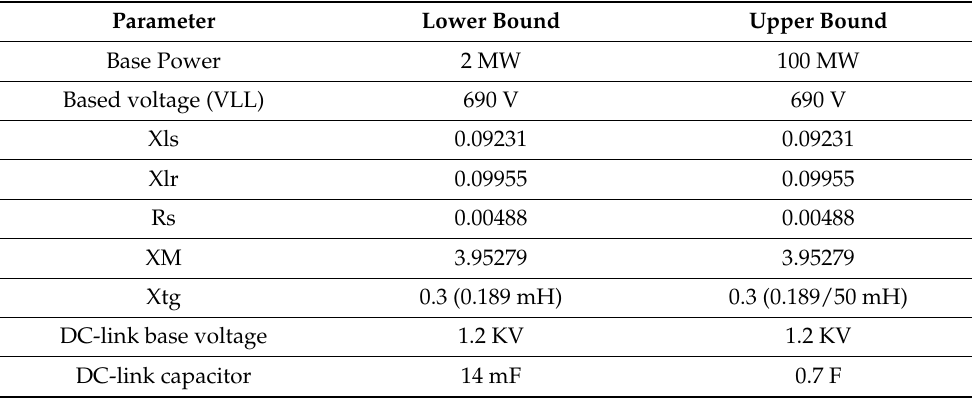
Table A2. Parameters of DFIG- Based Wind